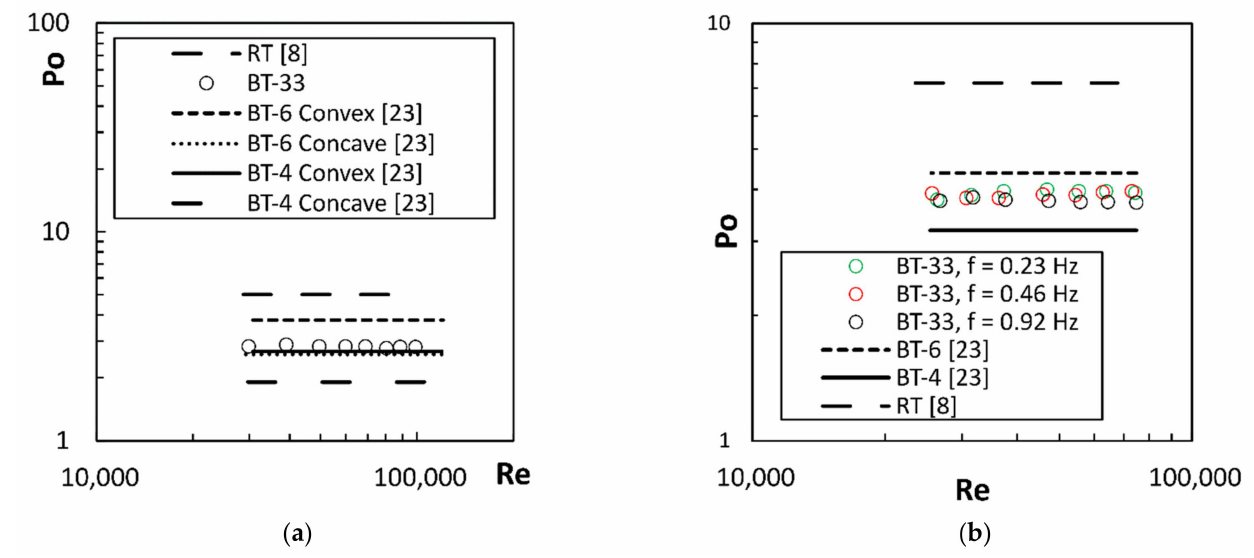
Figure 3. Power requirements for RT, BT-6, BT-33, and BT-4 impellers, ( a ) steady mixing ( b ) unsteady mixing.